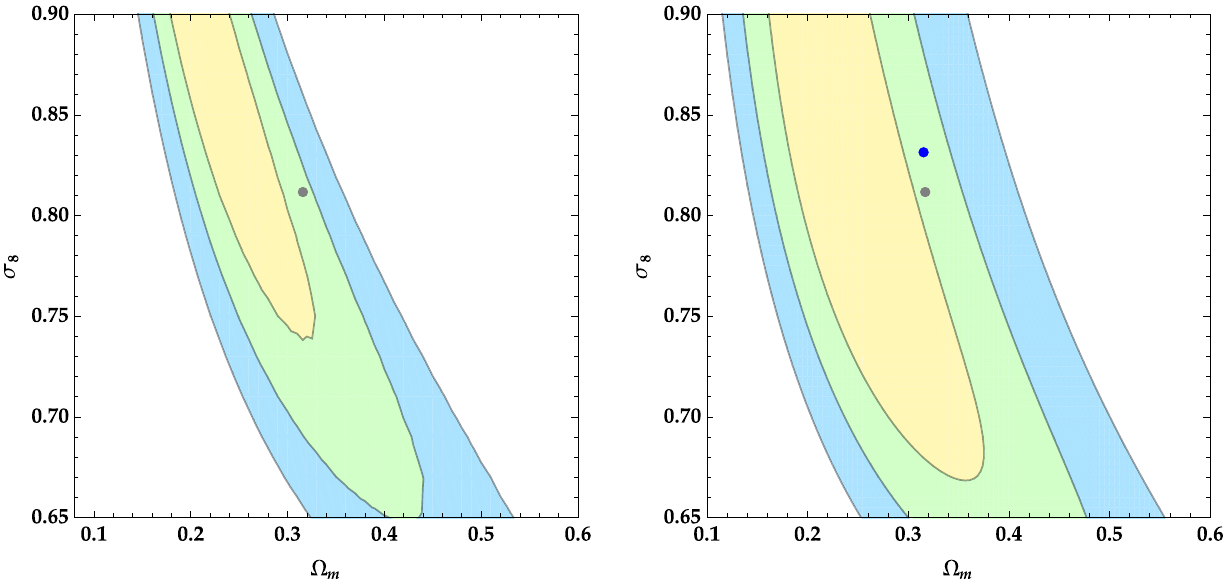
Fig. 4 σ 8 vs. Ω m 1 σ , 2 σ and 3 σ confidence regions. Left: maximized contours with w = − 1. The Planck 2018 point lays at 1 . 68 σ . Right: marginalized contours. The blue point corresponds to Planck 2015 and lays at 1 . 44 σ . The grey point corresponds to Planck 2018 and lays at 1 . 23